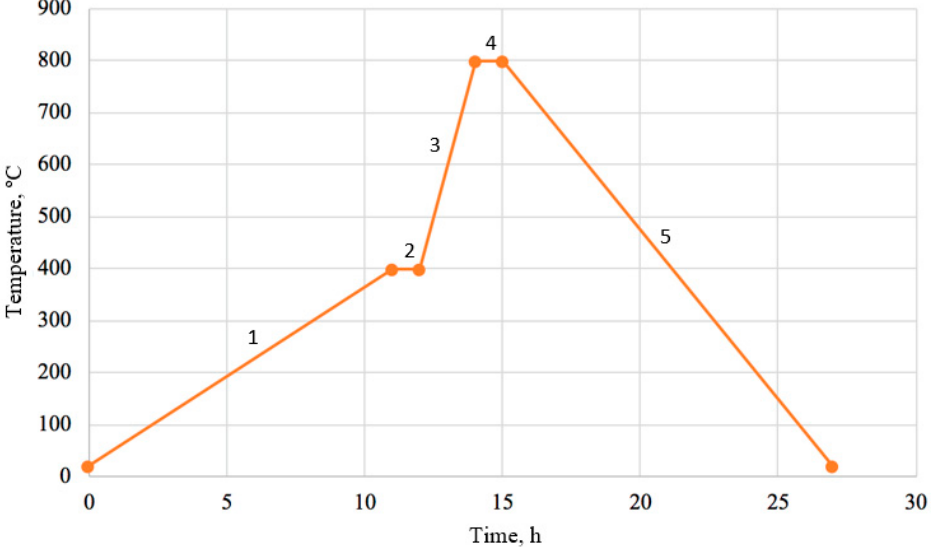
Figure 3. Scheme of pre-sintering process: 1—Heating with rate of 1 K/min. in H 2 up to 400 ° C; 2—Holding at 400 ° C for 60 min. in the Ar atmosphere; 3—Heating with rate of 5 K/min. in Ar up to 800 ° C; 4—Holding at 800 ° C for 60 min.; and, 5—Cooling to the room temperature.